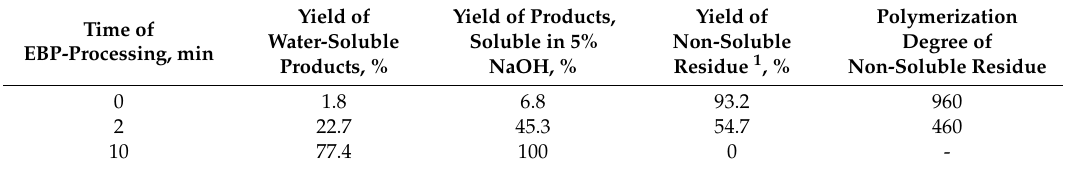
Table 1. The solubility changes of the EBP-treated cellulose sulfate in distilled water and 5% NaOH. Time of EBP-Processing, min